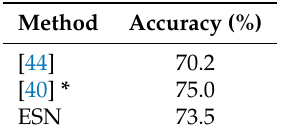
Table 2. Accuracy of the method on the Cornell Activity Dataset (CAD-120). * Koppula et.al reports on results with information about the objects in a